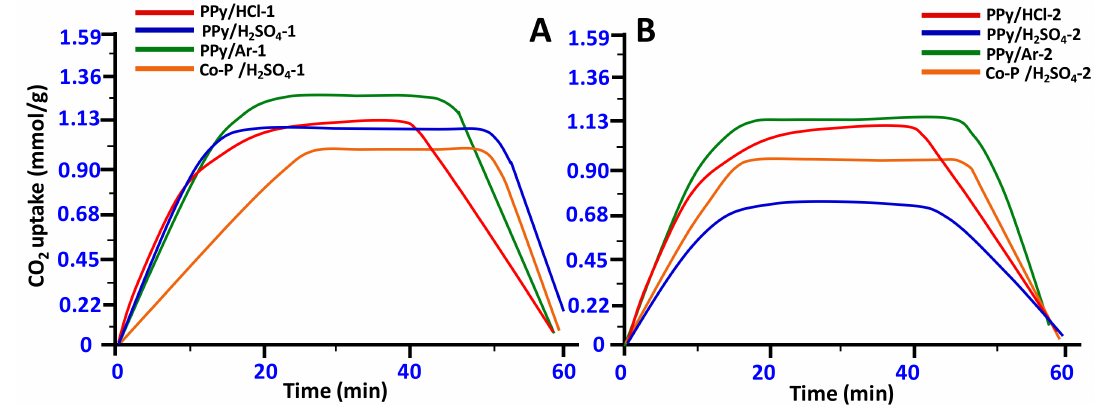
Figure 10. CO 2 adsorption isotherms measured by TGA-DSC for ( A ) amount of N-GOs obtained when carbonization and activation were carried using polymer: KOH at a ratio of 1:2 and ( B ) amount